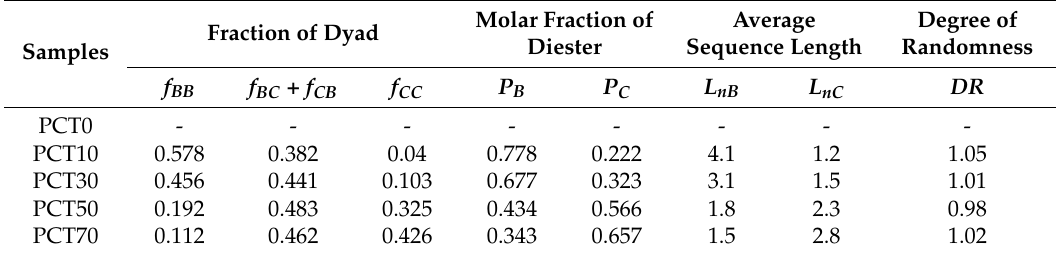
Table 3. Sequence distribution analysis of the (PBT-co-PCT)-b-PTMG copolymers.